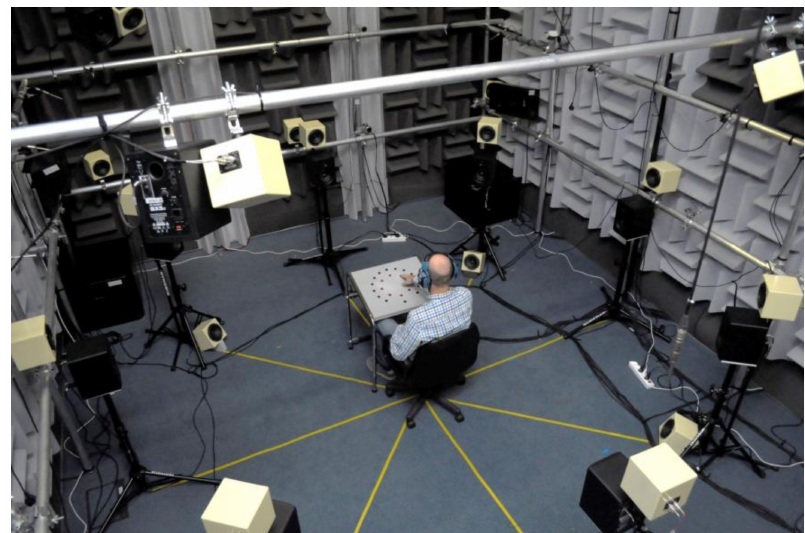
Figure 2. The experimental setup during the back-up alarm signal localization tests, performed with the participation of a subject wearing a level-dependent hearing